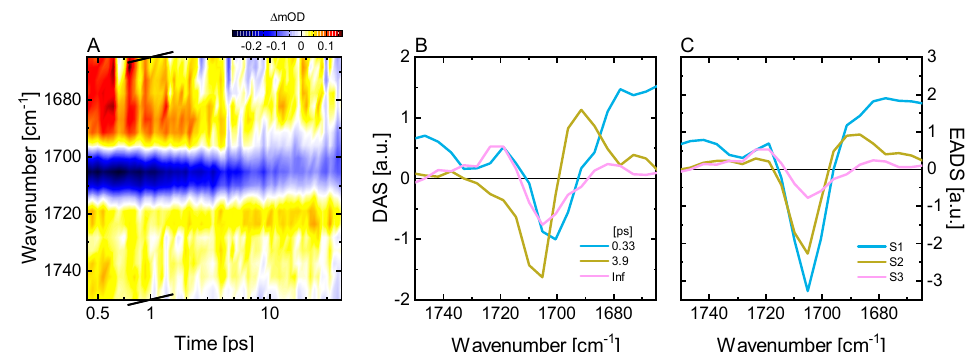
Figure 6. Ultrafast excited state dynamics of the P fr state in Syn Cph2 investigated in the IR spectral range. ( A ) TA data of the P fr → P r dynamics after excitation at 710 nm. ( B ) Corresponding decay associated spectra and ( C ) evolution-associated difference spectra (EADS) obtained from a sequential model fit of the data displayed in ( A ).